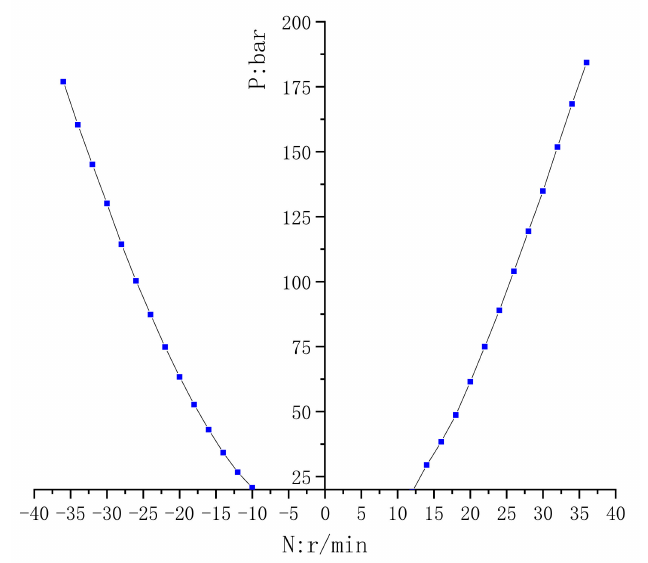
Figure 14. Dead-zone construction pressure